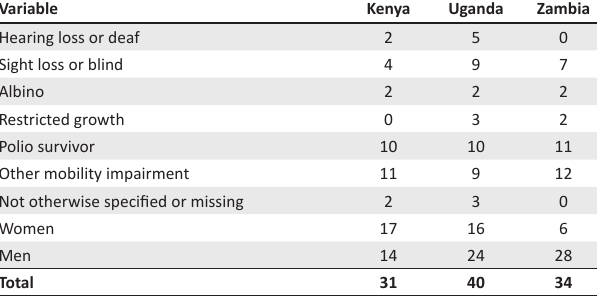
TABLE 1: Impairments of participants in